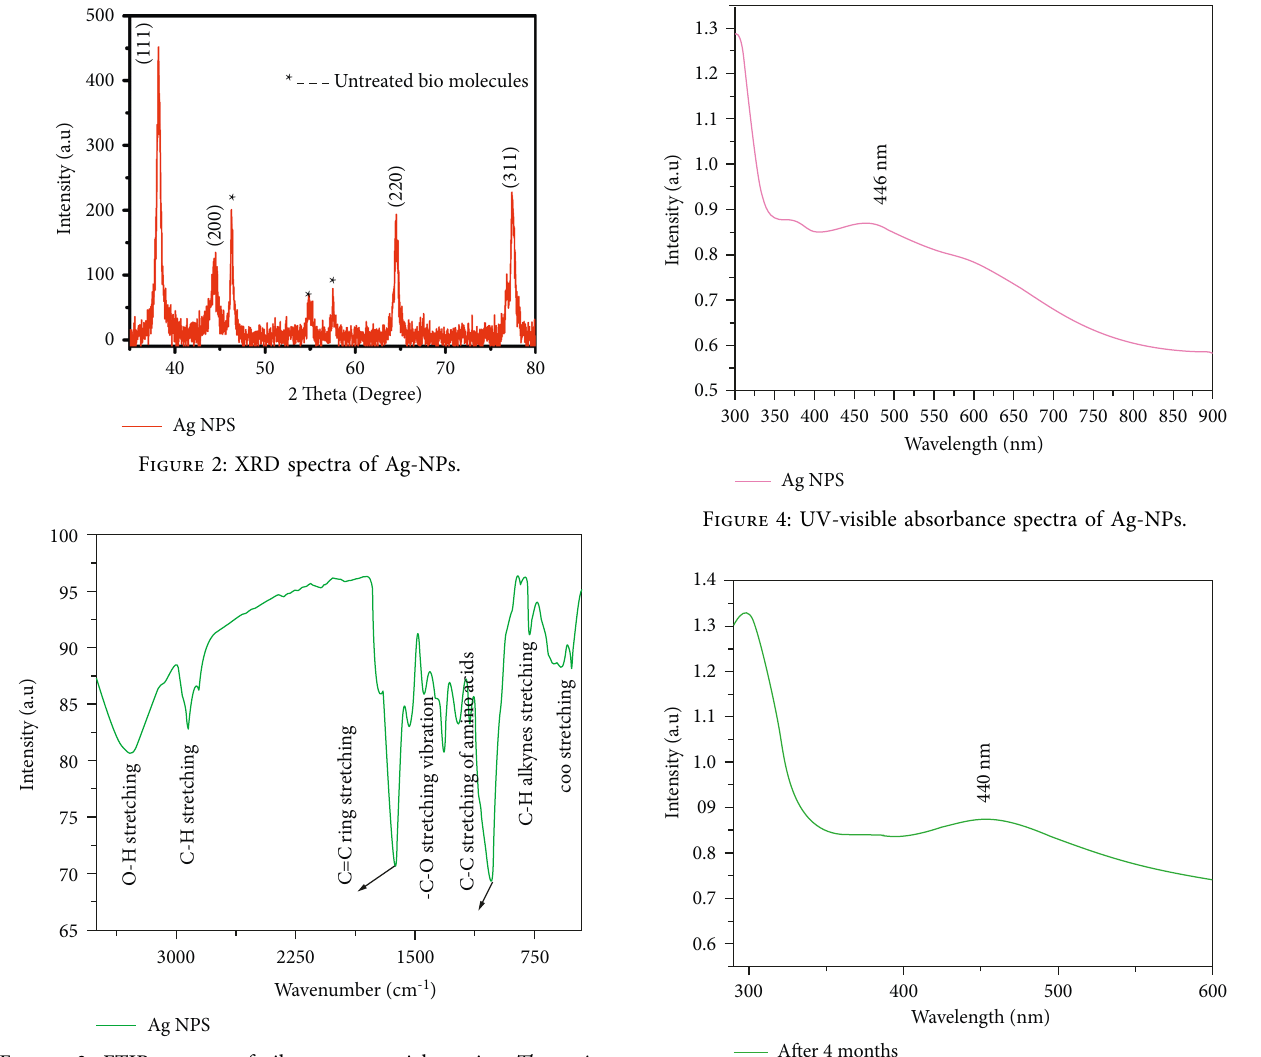
Figure 3: FTIR spectra of silver nanoparticles using Thespesia populnea bark extract.